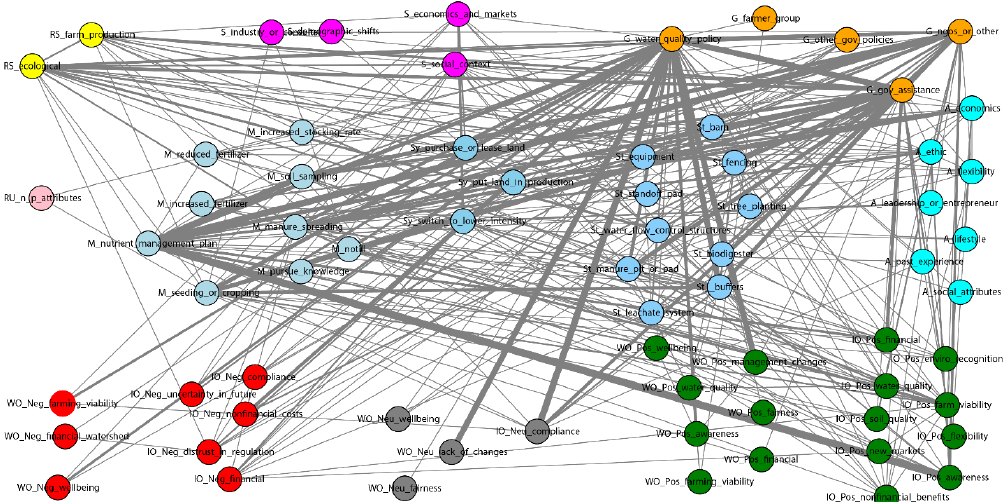
Figure A1.6. Vermont SES sub-category group mental model